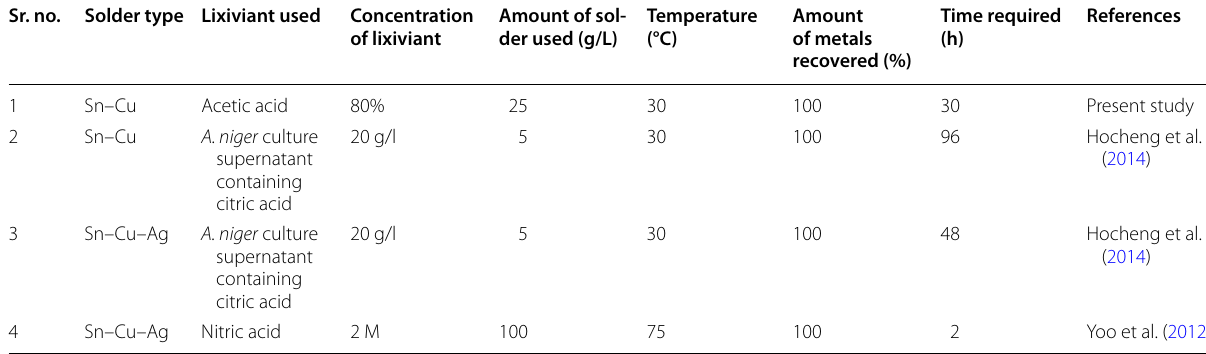
Table 2 Comparison of present study with existing literature Sr. no. Solder type Lixiviant used Concentration